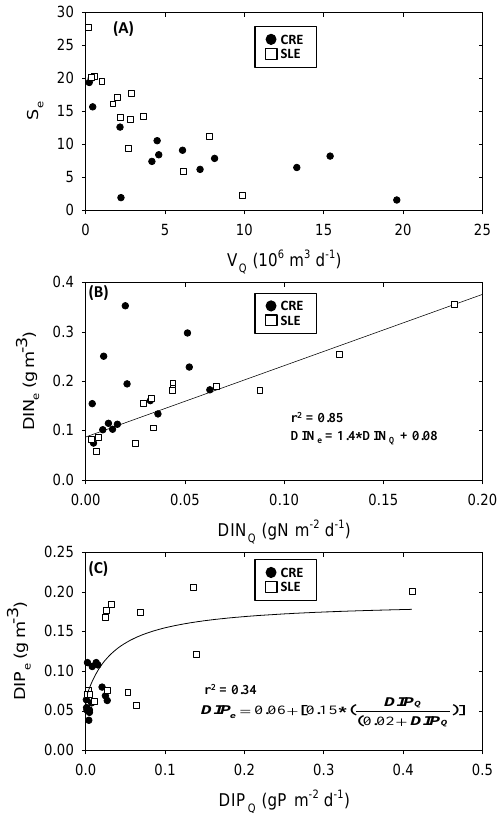
Fig. 6. Scatter plots from seasonal DIN and DIP budgets for CRE and SLE from 2002 to 2008. Estimated flushing time ( T f ; days) pro- vided the independent variable vs. (A) salinity; (B) estuary DIN concentration (gm − 3 ) ; (C) estuary DIP concentration (gm − 3 ). Re- gression lines, r 2 values, and equations provided for the SLE points